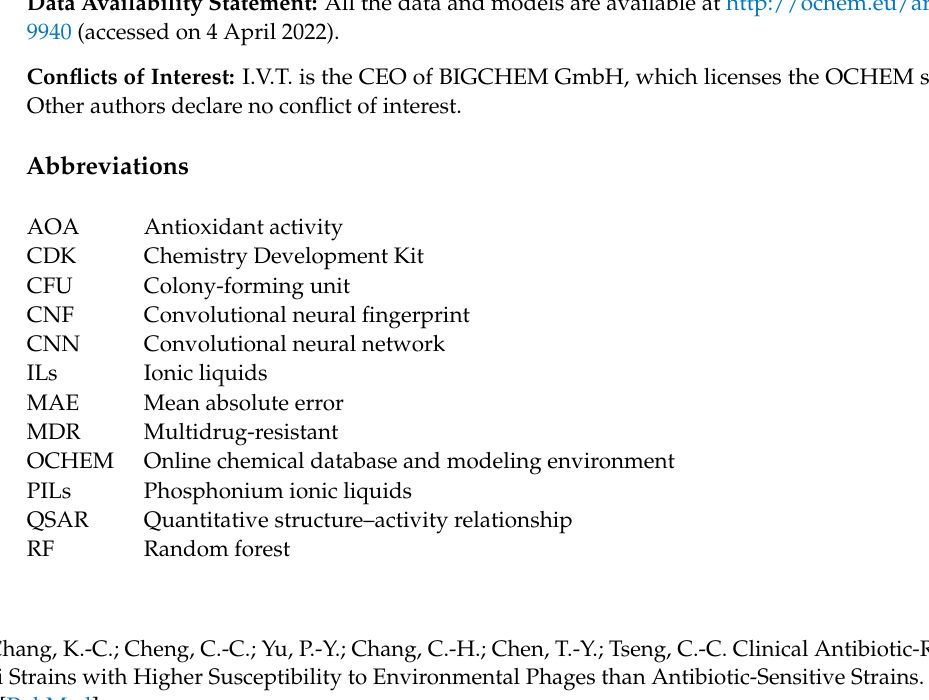
Table S1. Anti- A. baumannii activity calculated by using the consensus classification model for 11 virtual compounds. Table S2. Antioxidant activity predicted by using the consensus regression model for six tested ILs. Table S3. Comparison of the melting point values of the ILs with those previously reported in the literature